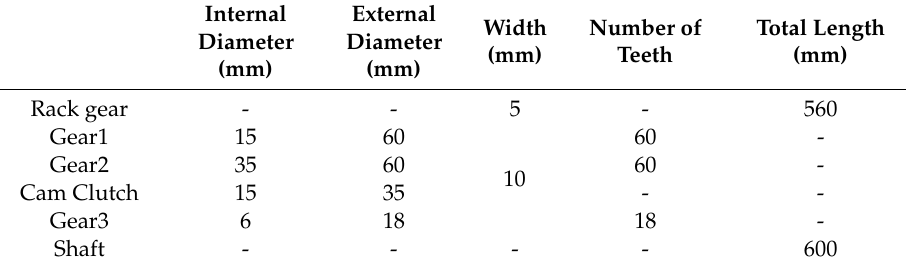
Table 2. Specification of respective parts in PTO